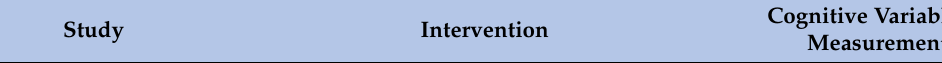
Table 3. Summary of included